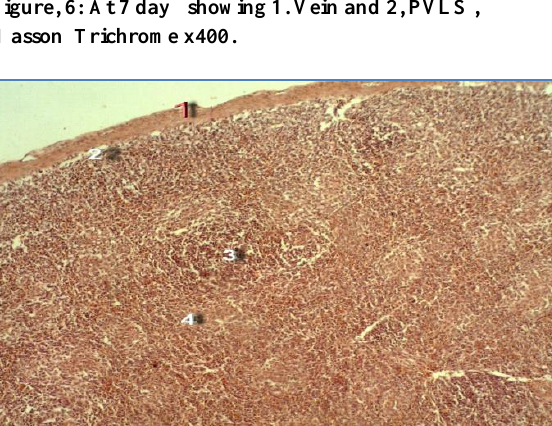
Figure, 6: At 7 day showing 1. Vein and 2, PVLS , Masson Trichrome x400.